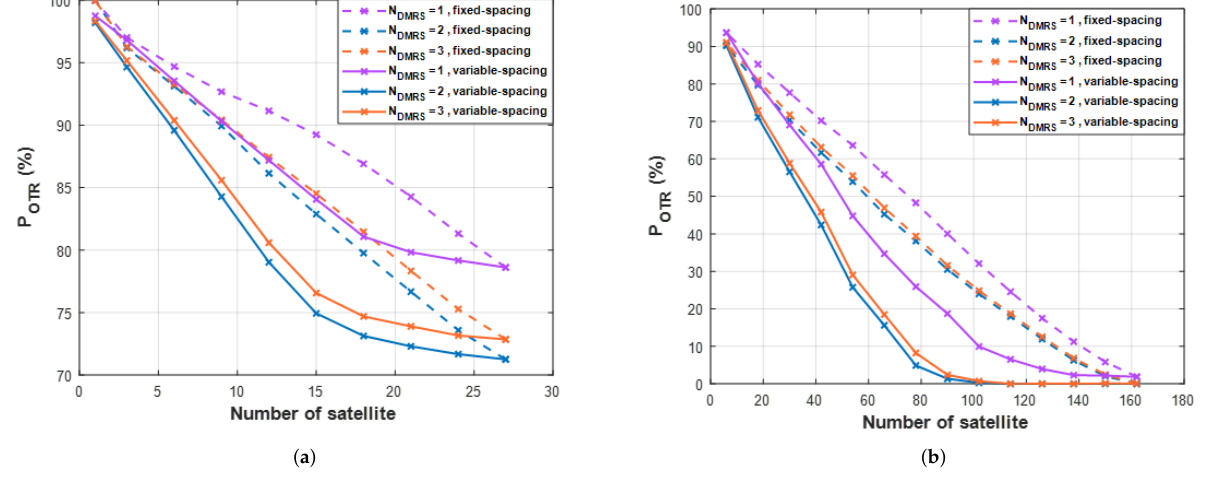
Figure 15. The per − day outage time ratio for different numbers of DMRS symbols per slot. ( a ) one orbit, ( b ) six